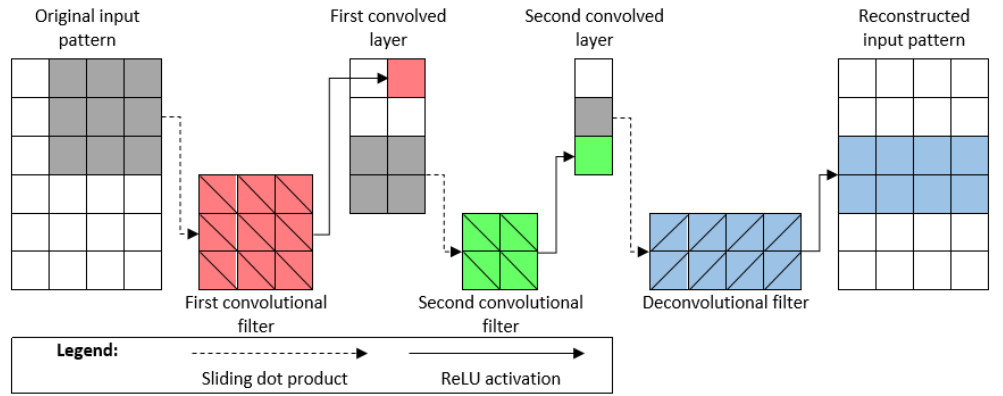
Figure 3. Simple 2-dimensional CAE with one convolutional filter per layer [20]. Shaded areas represent the subsets of each layer output used as receptive field for subsequent convolutional filters. In the example, the first convolutional filter maps nine input features to a single feature in the first convolved layer (red blocks), the second convolutional filter maps four features to a single feature in the second convolved layer (green blocks), and the deconvolutional filter maps a single feature into eight separate features in the reconstructed pattern (blue